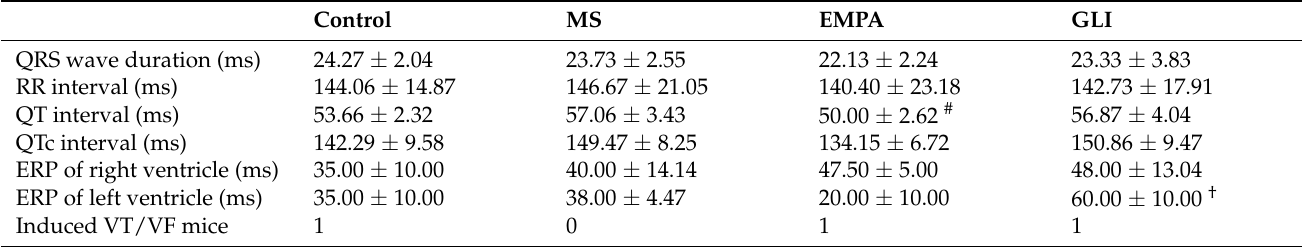
Table 3. ECG parameters and effective refractory periods (ERPs) of the study